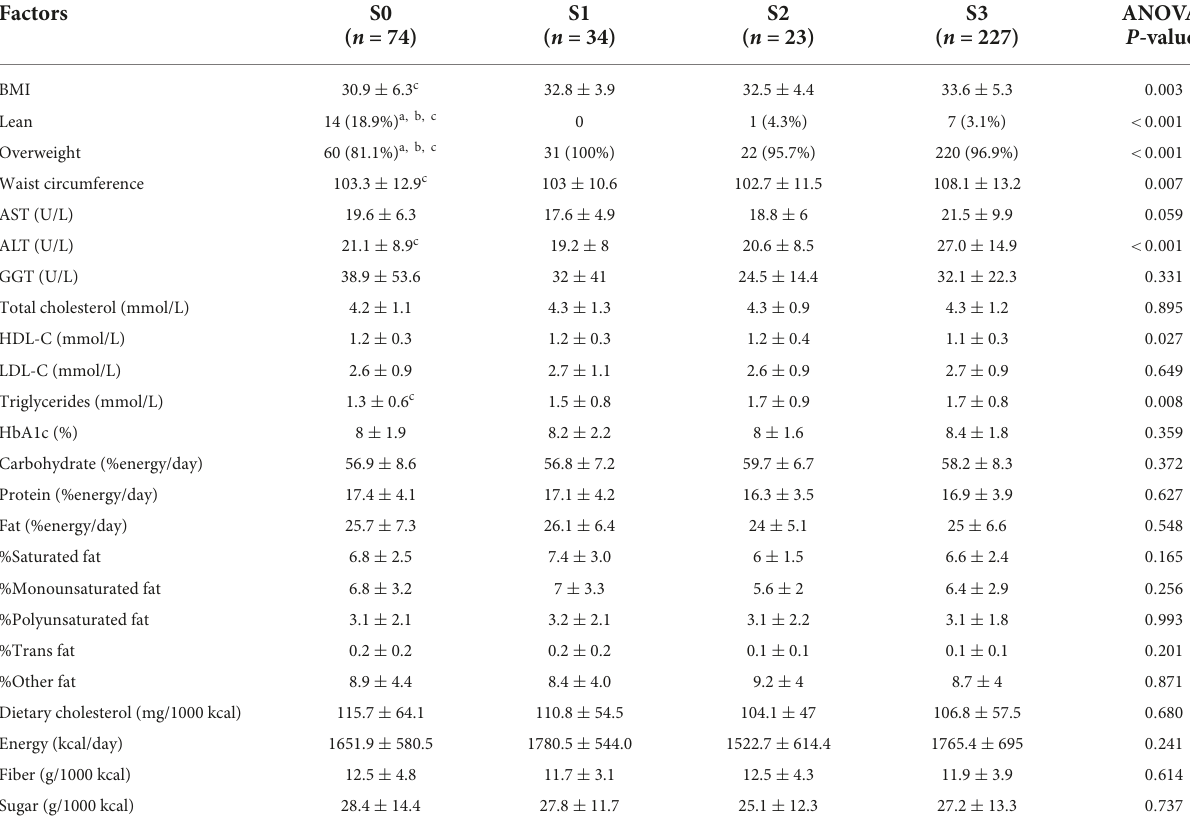
TABLE 2 Analysis of variance between hepatic steatosis severity and weight, biochemical, and dietary data, n =